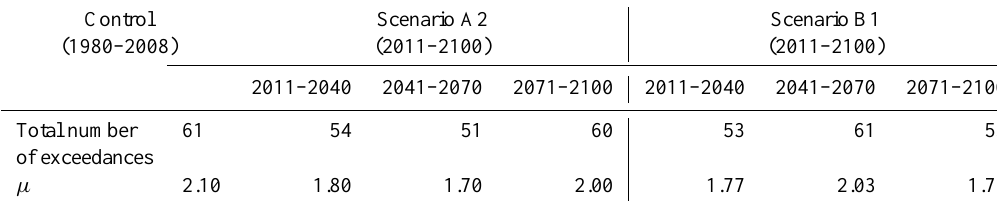
Table 4. Summary of the number of POT of the Anoia sub-basin for the three study periods and the two scenarios.